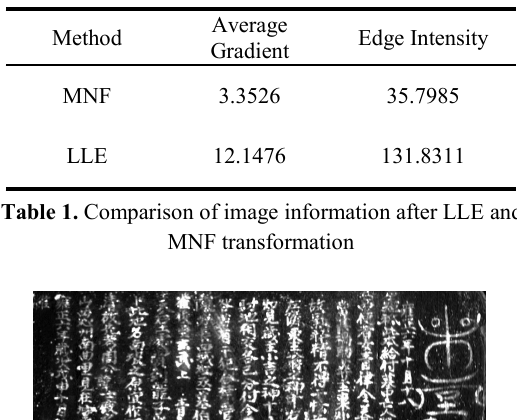
Figure 4. Abundance map of handwriting endmember In order to further enhance handwriting, spatial information and spectral information were combined. Firstly, the image with the maximum amount of information after LLE was normalized. Figure 3 and Figure 4 were weighted together to obtain the handwriting enhanced image. During the band addition operation, the weight of the two is set to 0.5. Then, HSV fusion was performed between the handwriting enhanced image and the true color image obtained from the reconstructed image to produce the fusion image. The comparison of handwriting enhanced image, handwriting fusion image, and ortho-image obtained by Nikon D850 digital camera were shown in